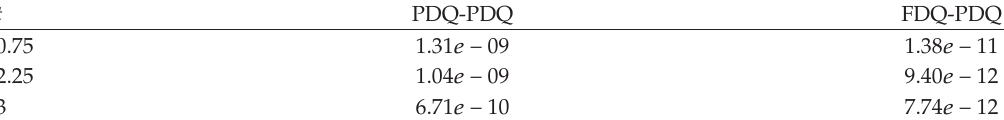
Table 8: RMS errors for u (cid:3) x,t (cid:4) of Problem 5 using M (cid:6) N (cid:6) 11 ,L (cid:6) 13.